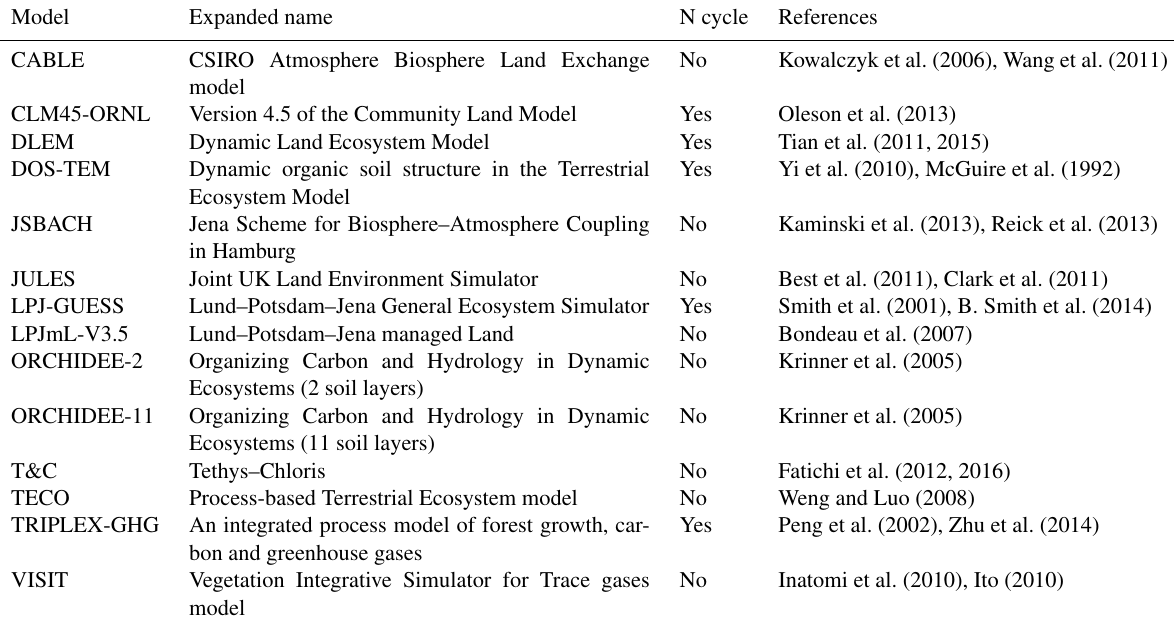
Table 2. Summary of ecosystem models used in this study, including model name, nitrogen (N) cycle and relevant references. Also see Tables S1–S14 in the Supplement for details of the simulated processes for grasslands in the ecosystem models, including the N cycle, phosphorus (P) cycle, carbon (C) allocation scheme, carbohydrate reserves, leaf photosynthesis and stomatal conductance including treatment of water stress, scaling of photosynthesis from leaf to canopy, phenology, mortality, soil hydrology, surface energy budget, root profile and dynamics, and grassland